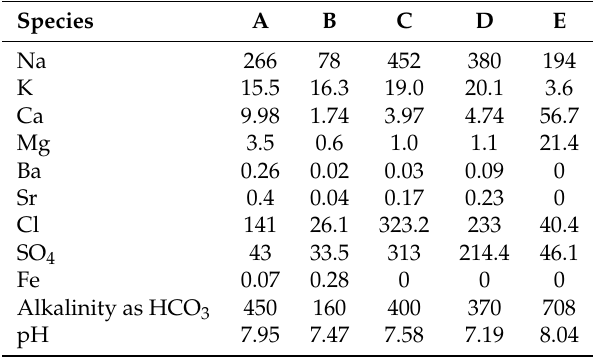
Table 1. Water chemistry analysis of the produced water from five thermal wells located in the Athabasca and Cold Lake areas. Values are in